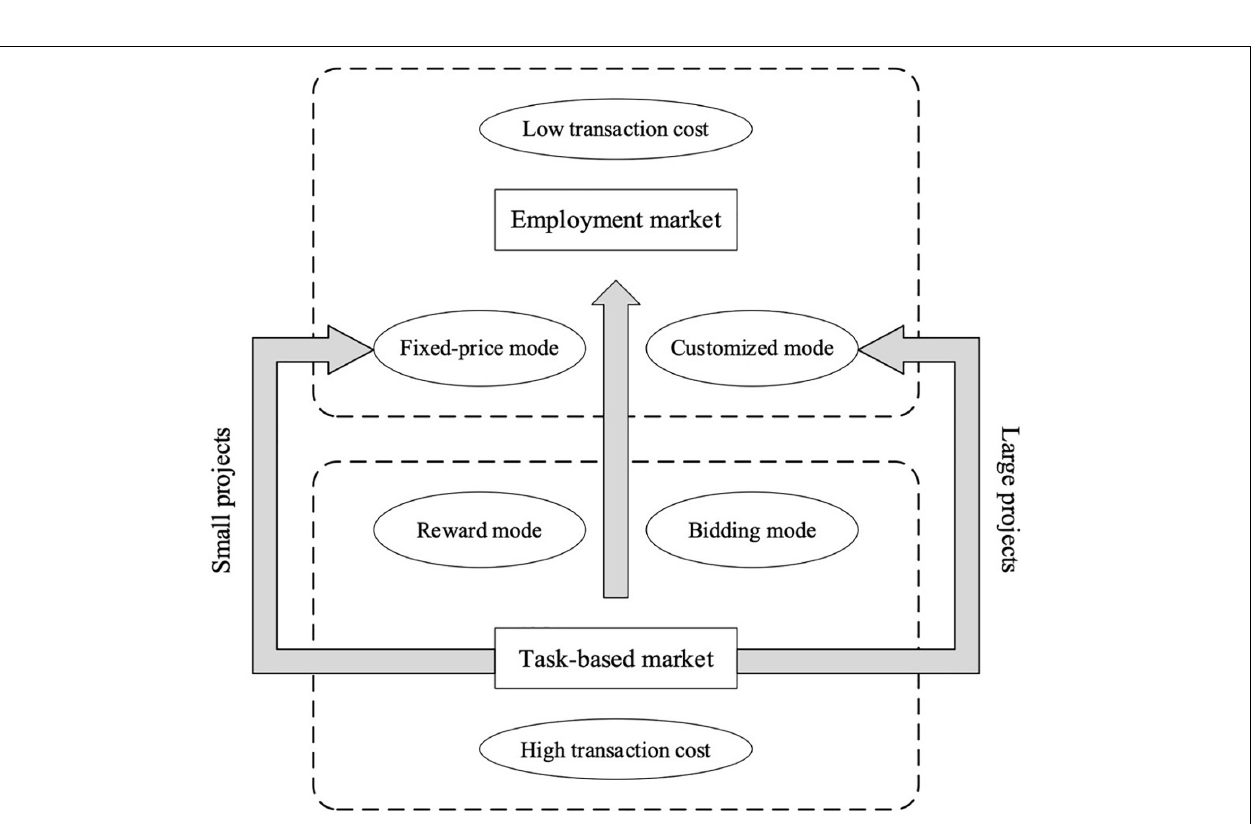
FIGURE 5 | Market transition trends of crowdsourcing